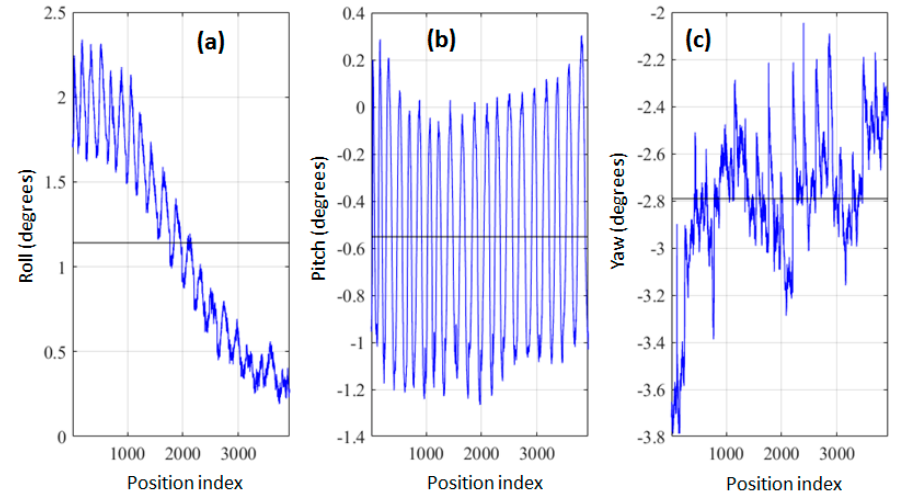
Figure 6. Example of measured values of roll ( a ), pitch ( b ), and yaw ( c ) angles provided by the IMU on-board the controller for a single 2D acquisition grid with the portable setup. The solid black line represents the average value.